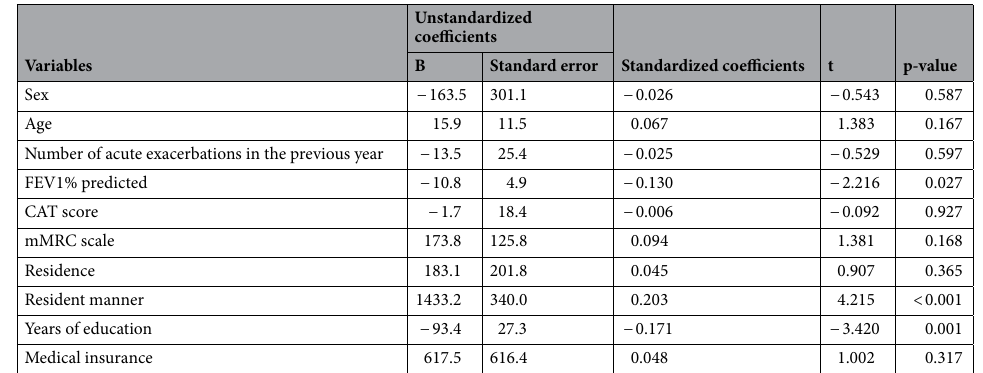
Table 5. Regression analysis of potential factors related to diagnostic delay. FEV1 forced expiratory volume in one second, CAT COPD Assessment Test, mMRC modified Medical British Research